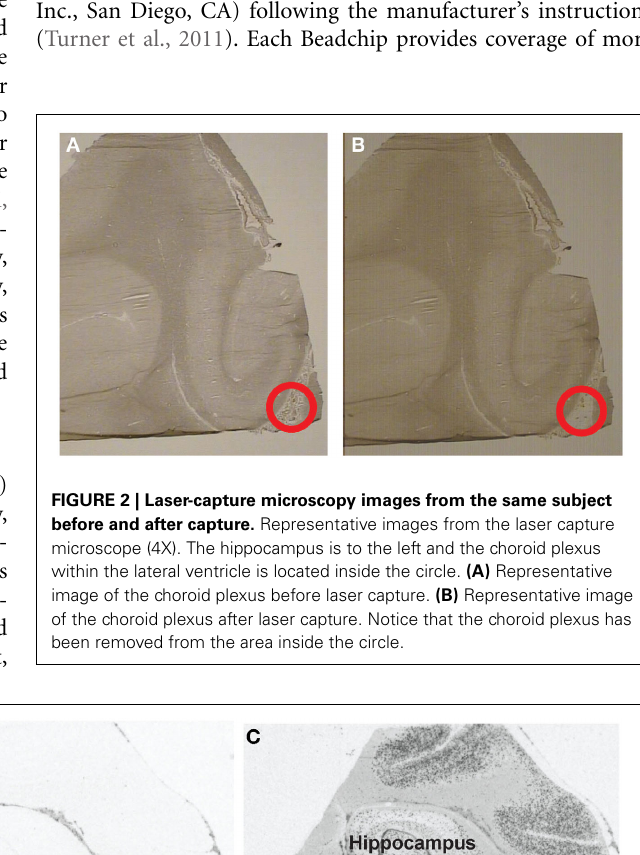
(B) Representative image of TTR gene expression used to identify the choroid plexus for each subject. The choroid plexus is the dark region ventral to the hippocampus. (C) Representative image of GAD67 and TTR